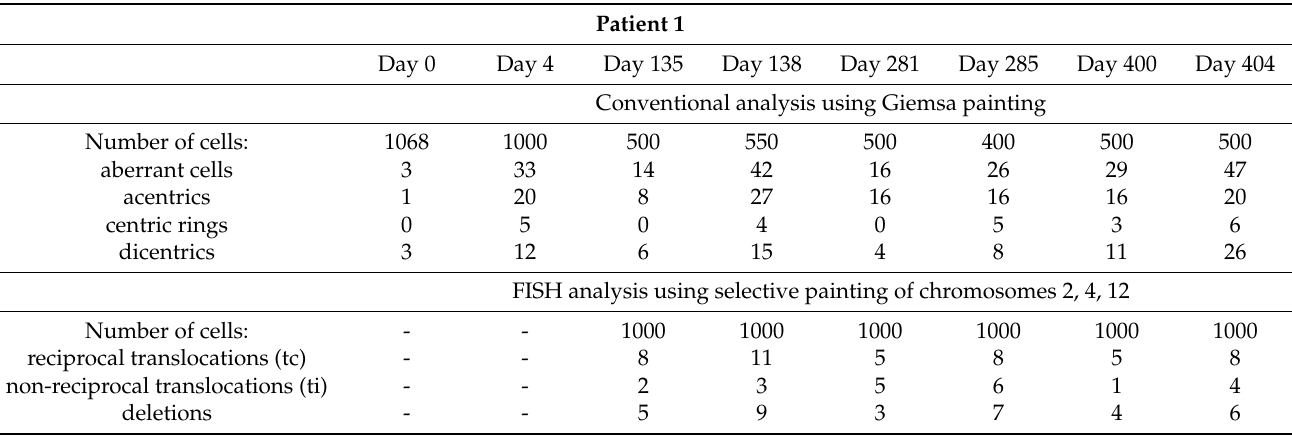
Table 1. Chromosome aberrations in blood lymphocytes of the DTC patients detected by different methods before and after RIT and in healthy